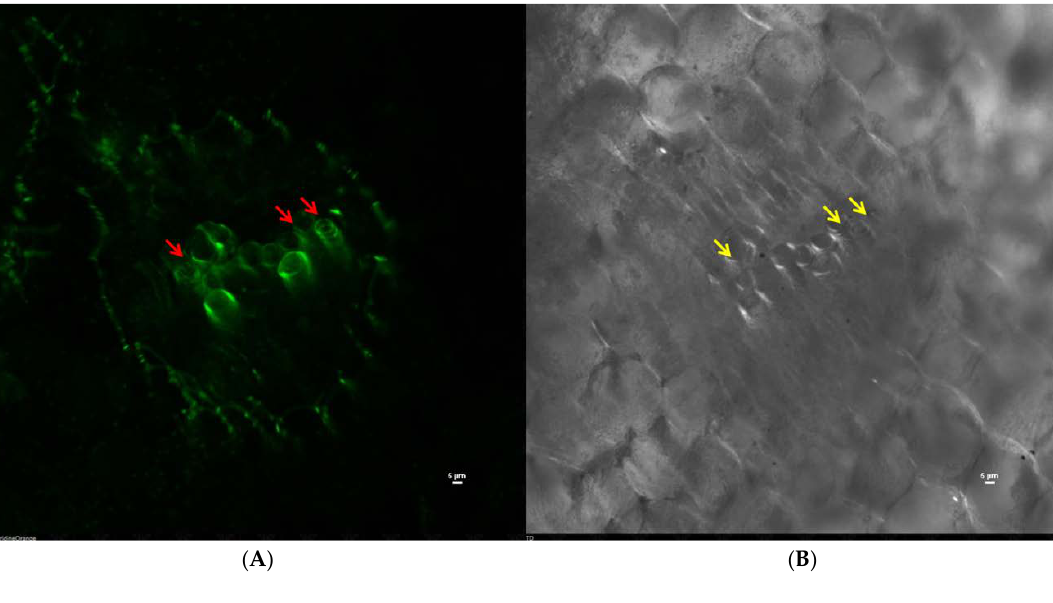
Table 2. Mortality in the tomato plants due to inoculation different physiological states of R.